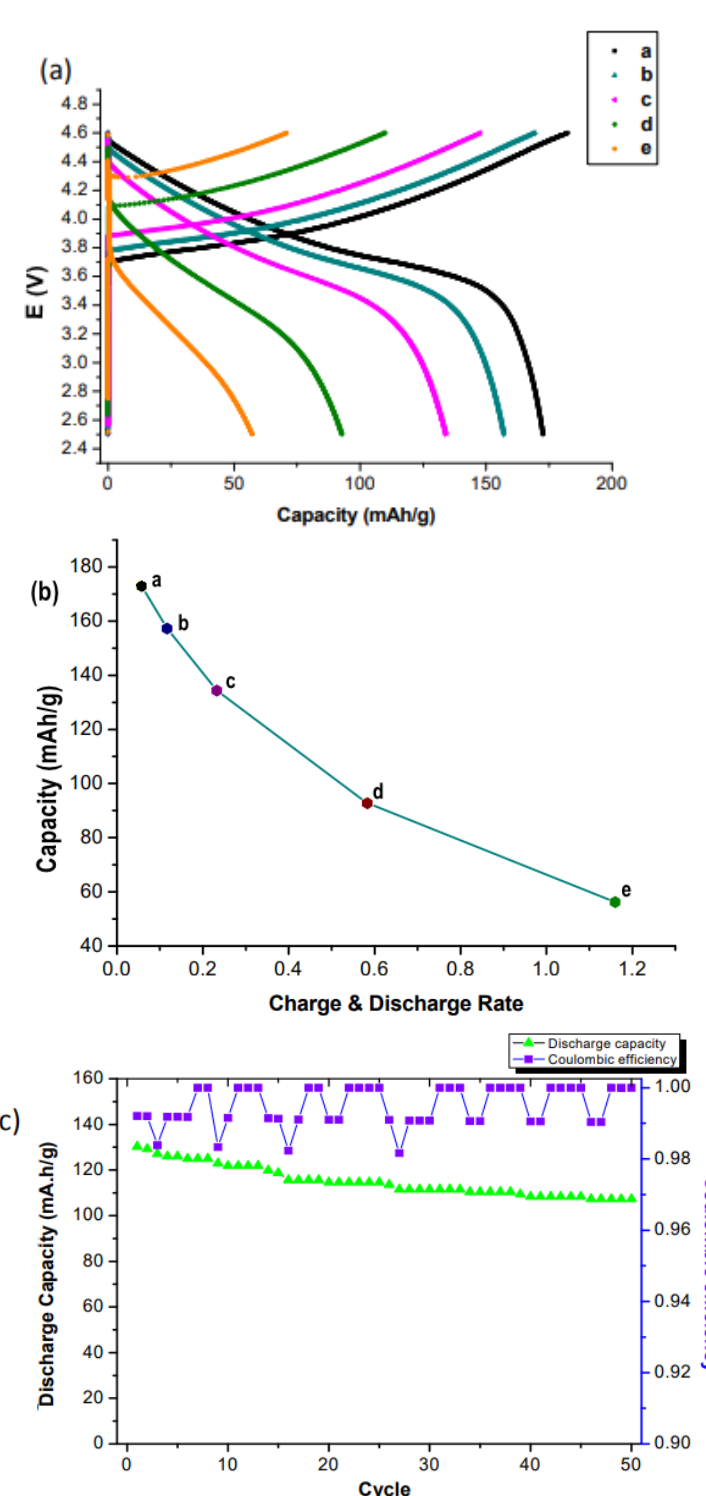
Figure 1. Electrochemical performance of synthesized NCM111, ( a ) charge and discharge curves for different rates (a 11.67, b 23.33, c 46.67, d 116.67, e 233.34 mA/g), ( b ) discharge capacity as a function of rate, ( c ) cycle test at a current density of 46.6 mA/g and voltage of 2.5–4.6 V. Used with permission of Royal Society of Chemistry, from Ref. [33]; permission conveyed through Copyright Clearance Center, Inc.